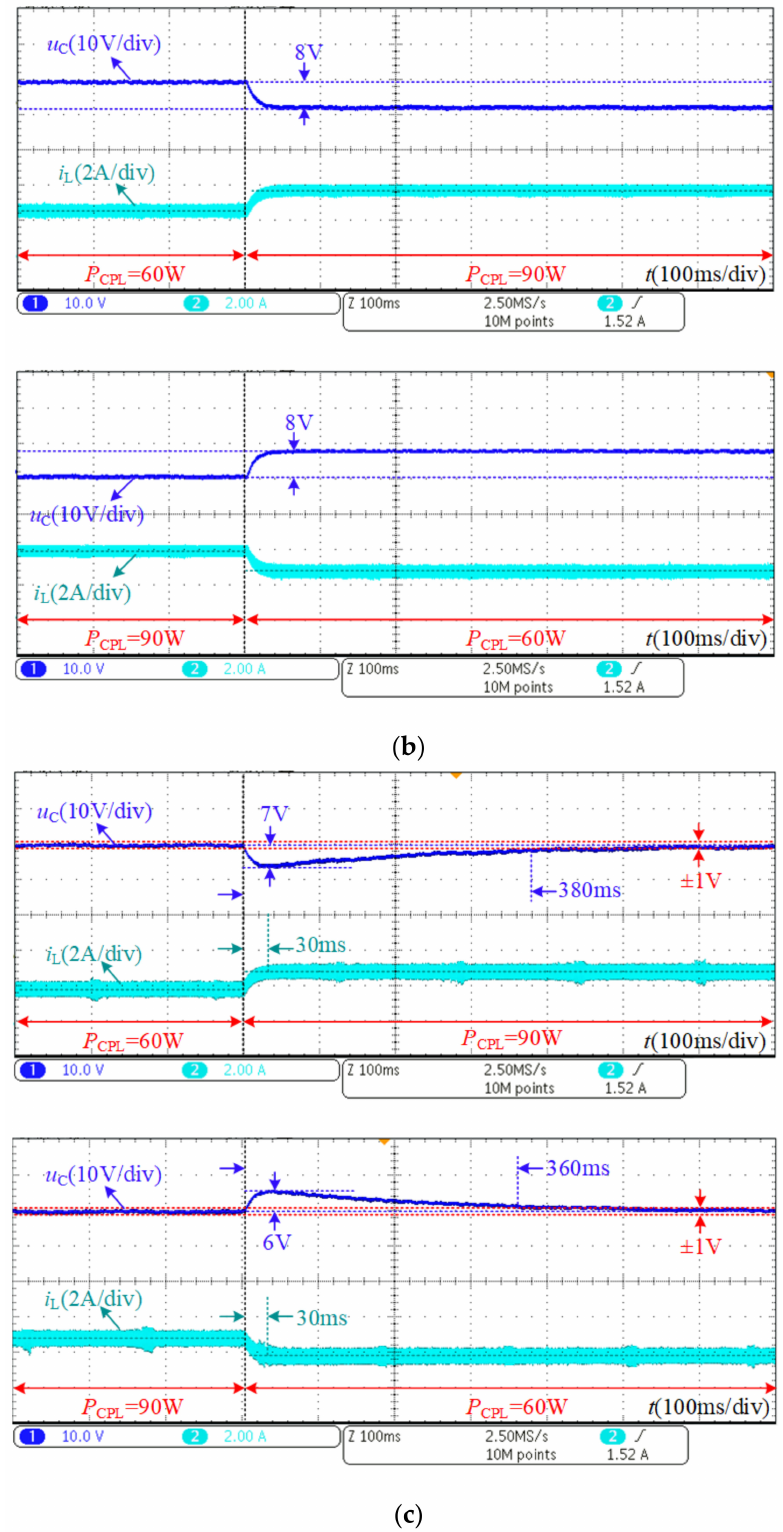
Figure 16. u C and i L experiment results of the different control strategies when CPL steps up and down (60 W to 90 W and 90 W to 60 W, respectively). ( a ) The proposed control strategy; ( b ) PBC; ( c )